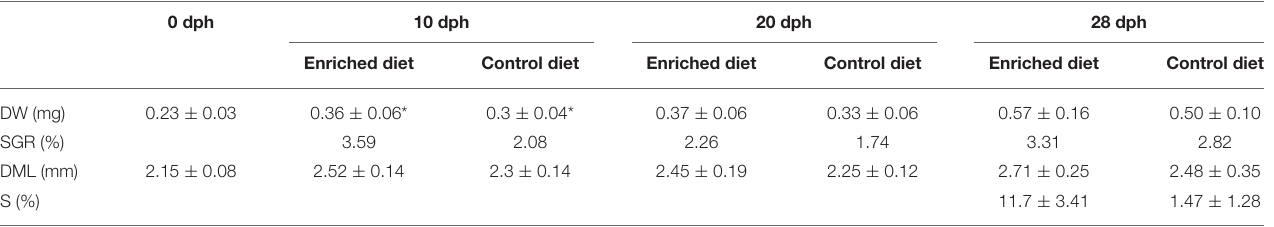
TABLE 1 | Data of growth (reported as DW, dry weight; SGR, specific growth rate; DML, dorsal mantle length) and survival ratio (S) of paralarvae reared with control and enriched